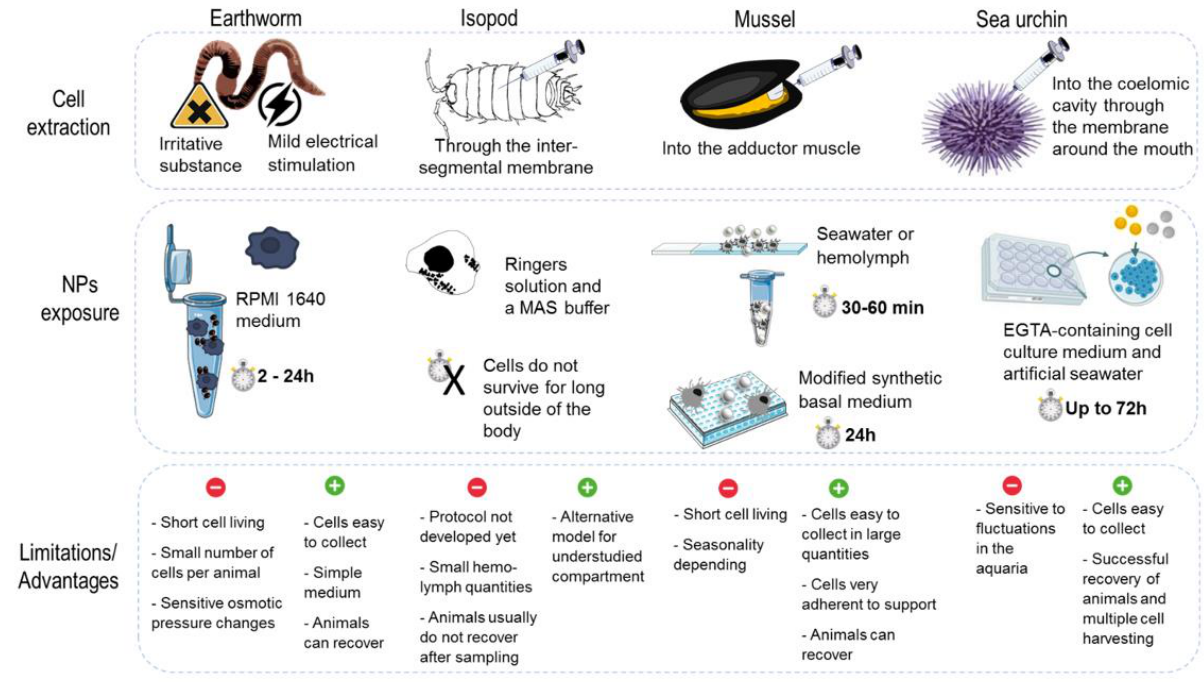
Figure 4. The different in vitro approaches and NPs exposure parameters encountered across the selected